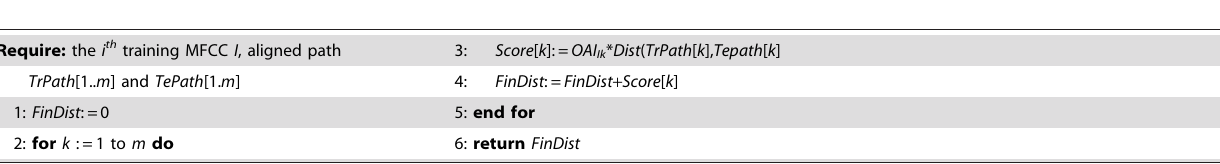
Table 2. Algorithm 2: Similarity Score of Normalized Training and Testing